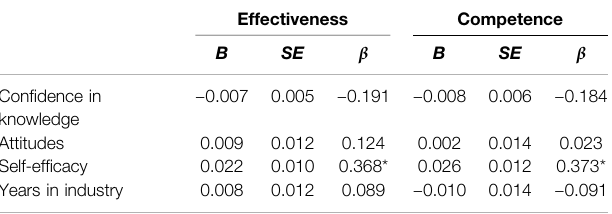
B ,unstandardizedregressionweights: SE ,Standarderrorfortheunstandardizedbeta; β , standardized regression weights. * p < 0.05. Data in this table were derived from 56